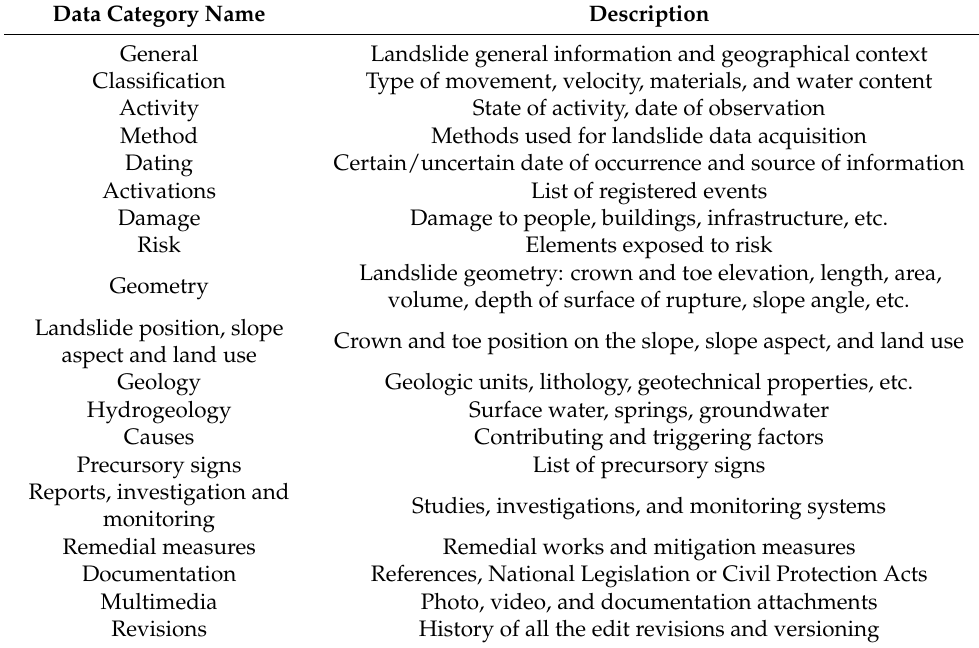
Table 1. Italian landslide inventory—data